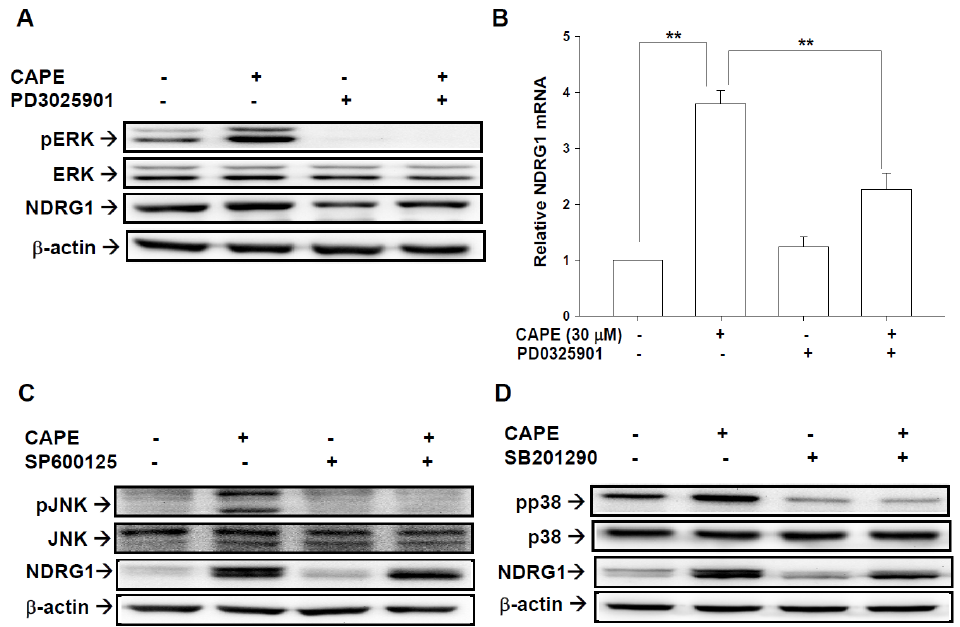
Figure 6. Inhibition of phosphorylation of MAPK blocks CAPE-enhanced expression of NDRG1 in TW01 cells. ( A )The expression levels of ERK, p-ERK, NDRG1, or β-actin after pretreatments with (+) or without (−) PD0325901 for 1 h before 30 μM CAPE treatment in TW01 cells were determined by immunoblotting and RT-qPCR ( B ) assays. TW01 cells were pretreated with (+) or without (−) SP600125 ( C ) or SB202190 ( D ). The protein levels of JNK, p-JNK, p38, p-p38, NDRG1, or β-actin in CAPE-treated TW01 cells were determined by immunoblotting assay. (** p < 0.01).